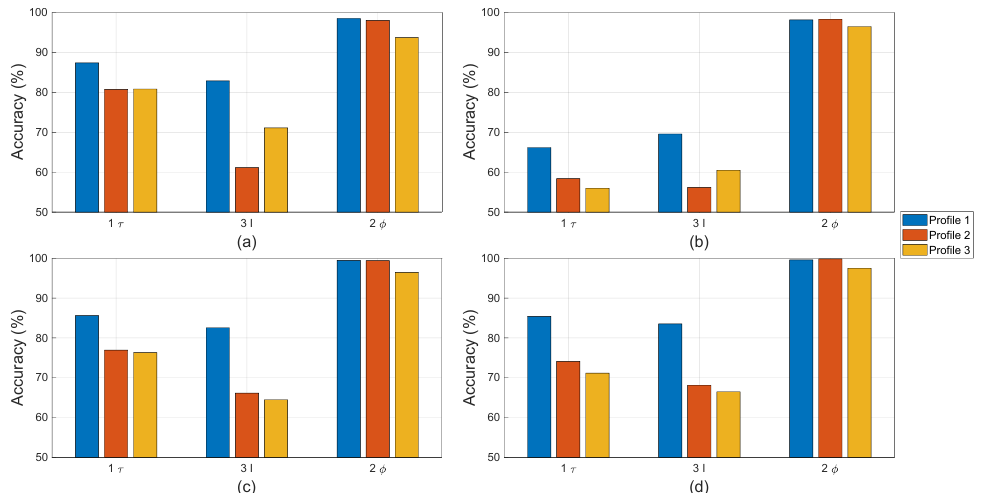
Figure 13. Detection accuracy with demagnetisation alone obtained by ( a ) EDT, ( b ) KNN, ( c ) SVM, and ( d )